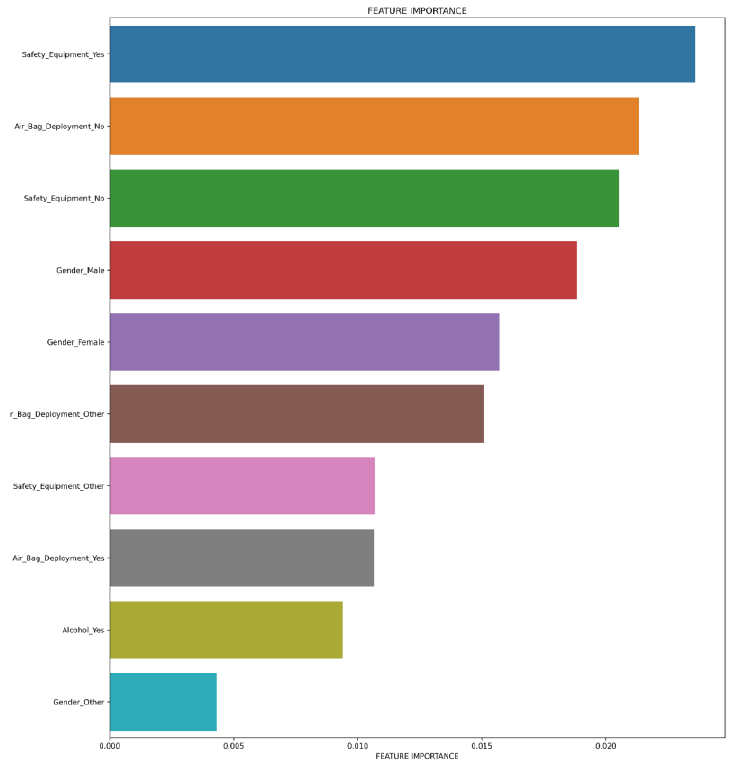
Figure 6: Feature importance of top 10